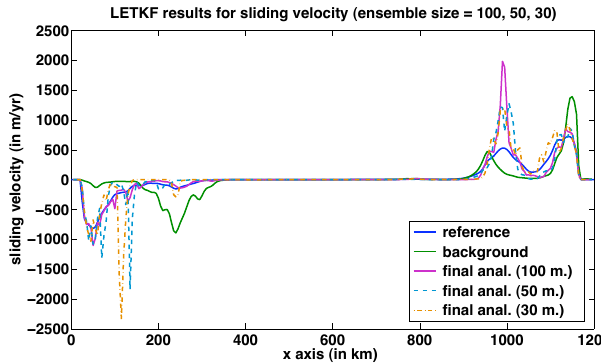
Fig. 17. Absolute difference between results and reference for the bedrock topography after 20 years of the LETKF with inflation. The background (green) is compared to the analyses for various ensem- ble sizes: 100 members (purple), 50 members (cyan), and 30 mem- bers (orange). RMS error evolution is synthesised in Table 3.